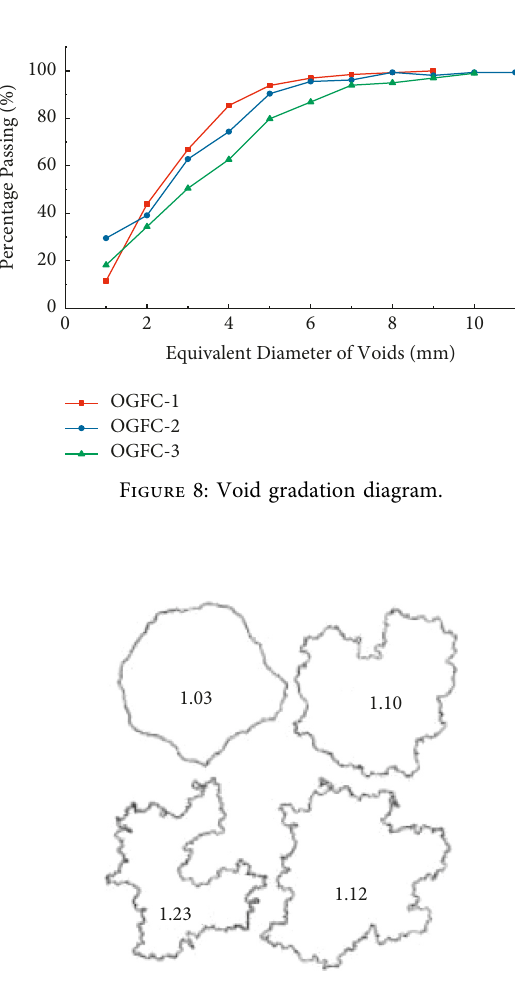
Figure 9: Fractal dimensions of four different rules and smoothness